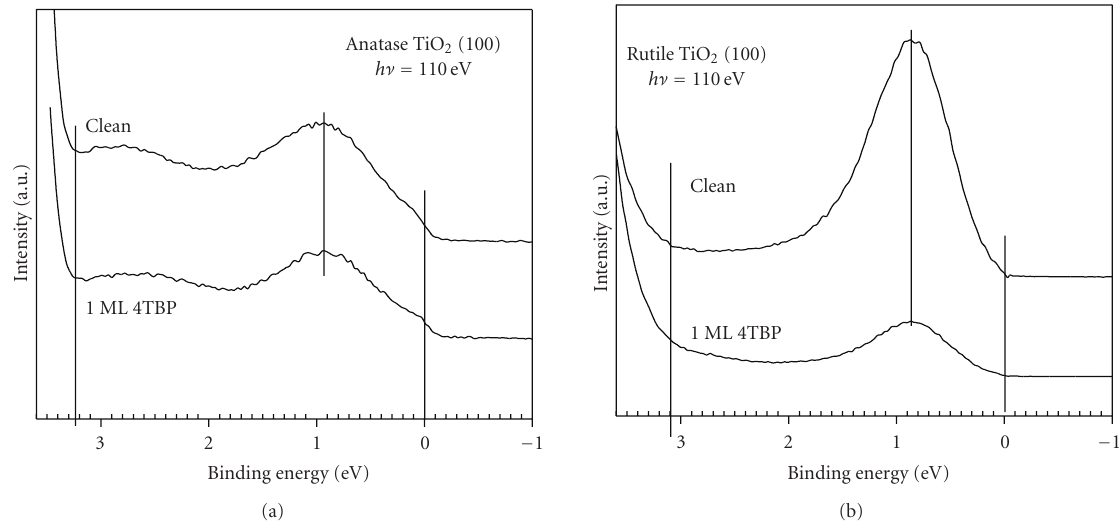
Figure 4: Spectra from the top of the valence band and the Fermi level region from 4TBP/TiO 2 interfaces compared with that of clean